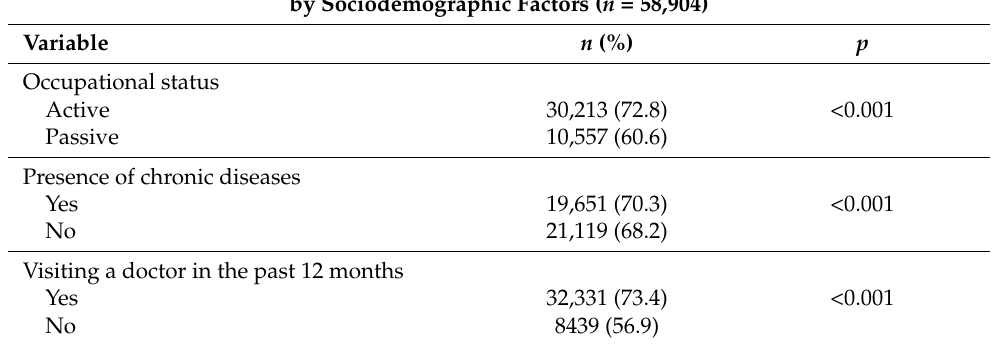
Table 4. Cont. Cervical Cytology Test in the Last 3 Years—Percentage of Respondents